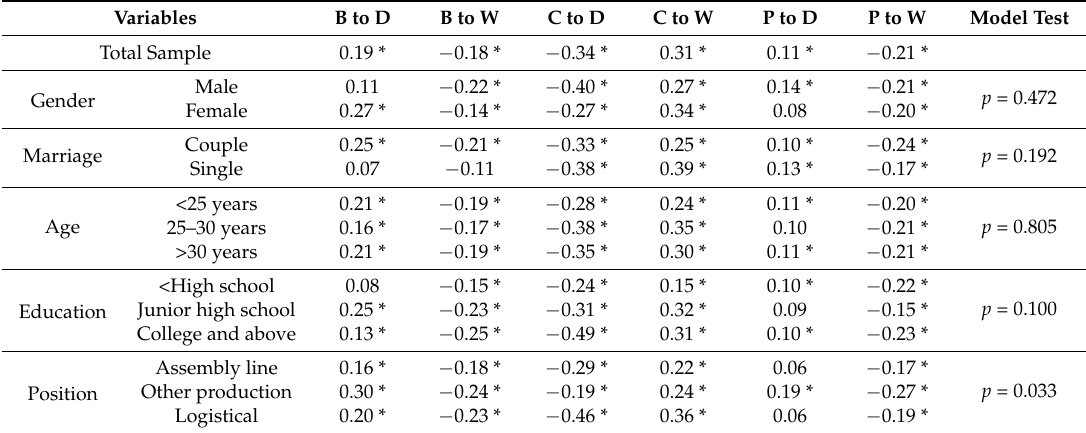
Table 3. Path Coefficients of the Structural Model in the Job Burden–capital Model of Depression and Well-Being for the Whole Sample and for the Multi-Groups